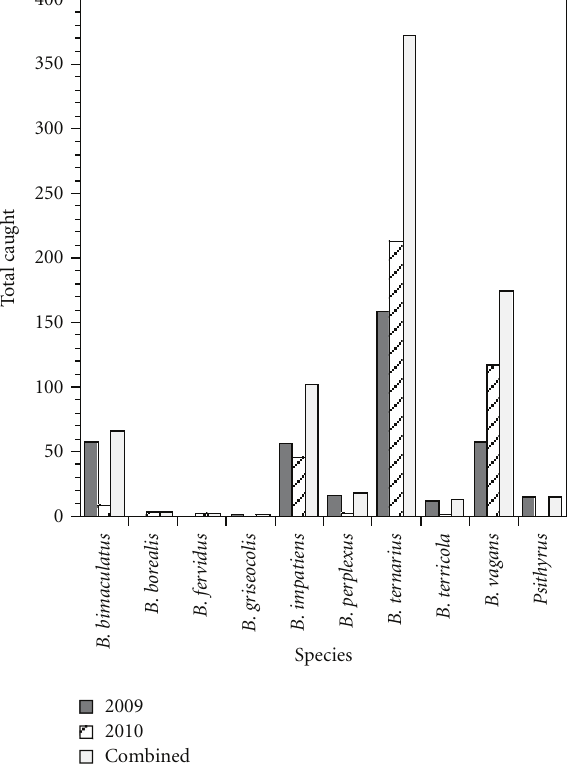
history of commercial bumblebees (Student’s two-tailed test, t = 0 . 15, df = 16, P = 0 . 51).